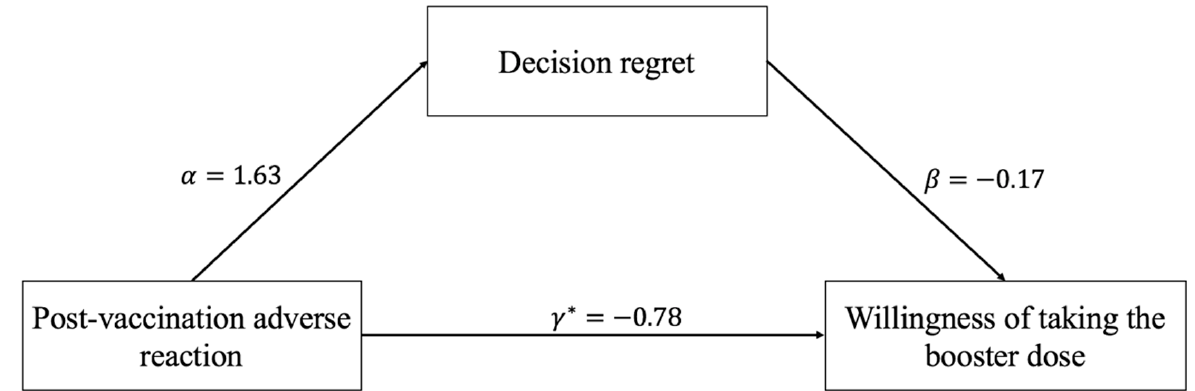
Figure 2. Pathway between post-vaccination adverse reaction, decision regret, and willingness of taking the booster dose. The description of α , β , and γ ∗ can be found in Equations (1)–(3). Firstly, the effect of post-vaccination adverse reaction on participants’ willingness to take the booster dose was significant ( p -value < 0.001). Compared with participants